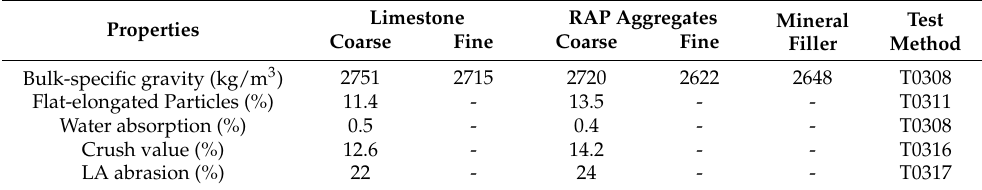
Table 5. Physical properties of the aggregates tested according to JTG